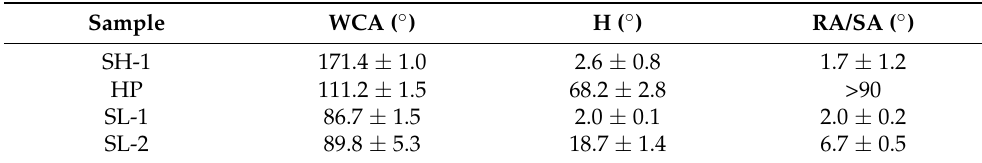
Table 1. Wettability at 23 ◦ C ± 2 ◦ C and standard